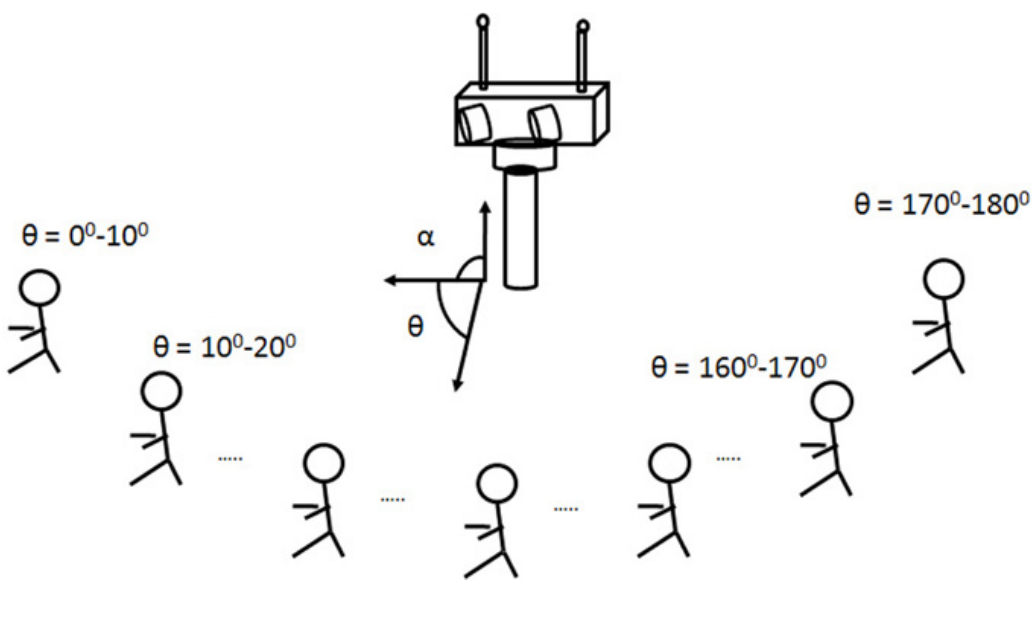
Figure 2. Reference system for egocentric azimuth and elevation angles computed through visual and audio